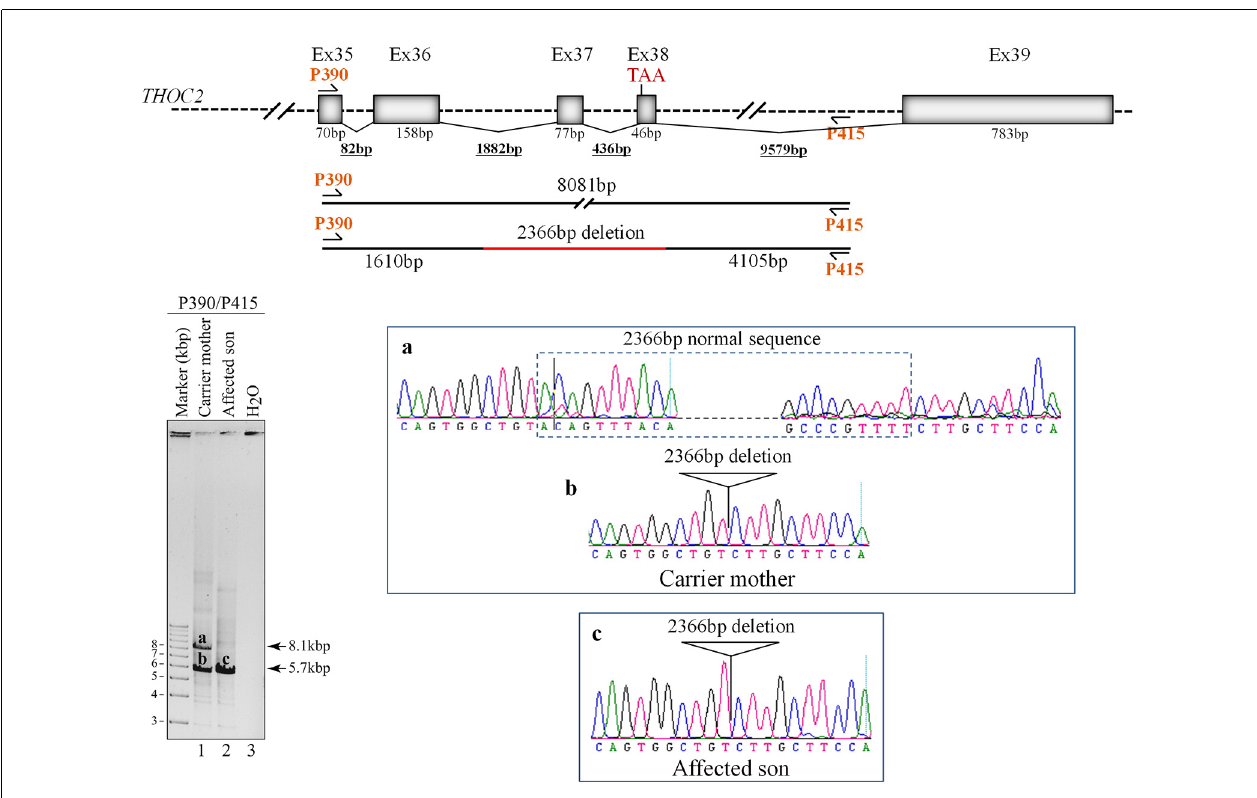
FIGURE 4 | Del-Ex37-38 results from the deletion of approximately 2.4 kb genomic DNA (chrX:122743574-122745939) flanking the Ex37-38. Sequences around the deleted target region were amplified from the affected son and carrier mother’s blood gDNA using P390/P415 primers using LongAmp Hot Start Taq 2 × Master Mix, resolved on agarose gel and bands a-c were eluted and Sanger sequenced. Positions of the P390/P415 primers and sequencing chromatograms (a–c) around the deleted gDNA regions are